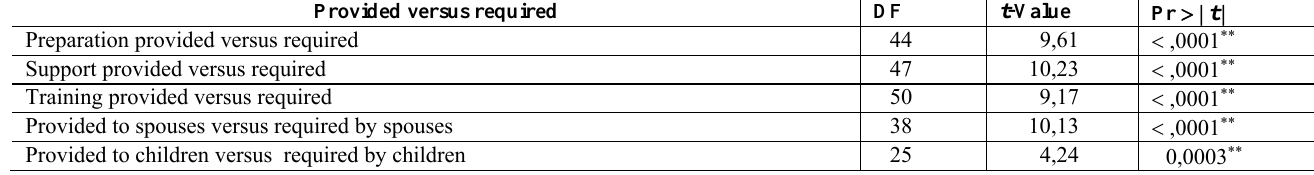
Table 7: Paired t -test section totals Provided versus required DF Preparation provided versus